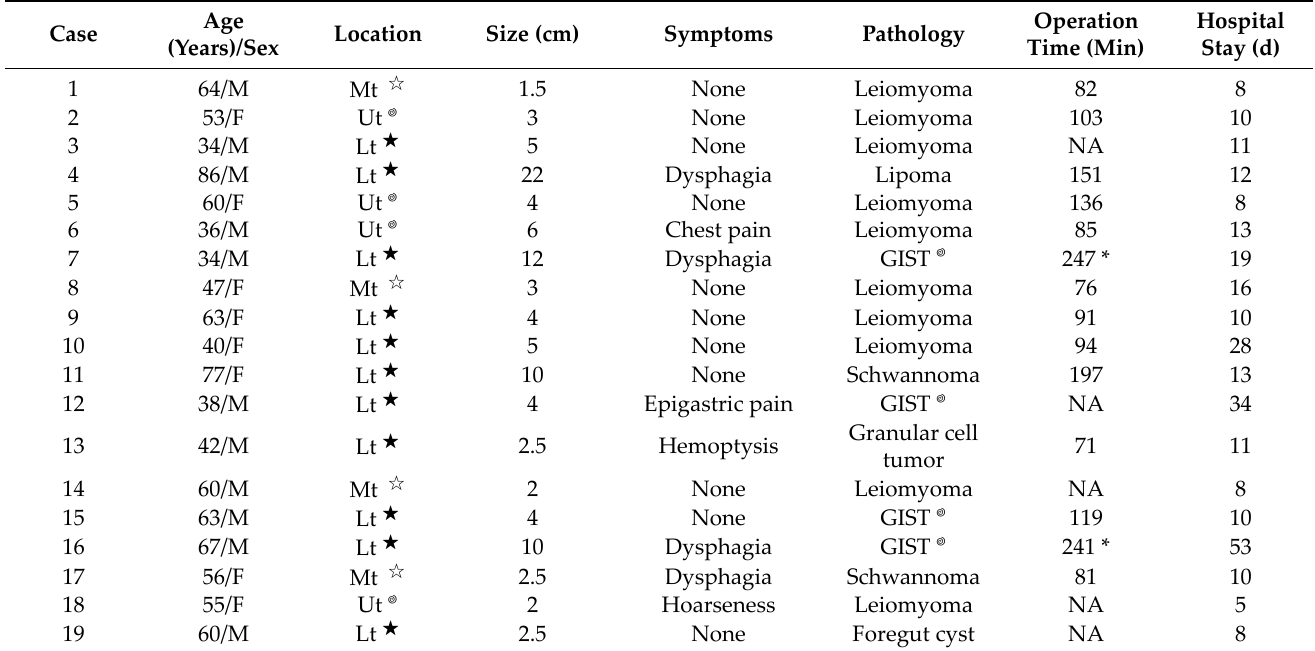
Table 2. Case series presentation.